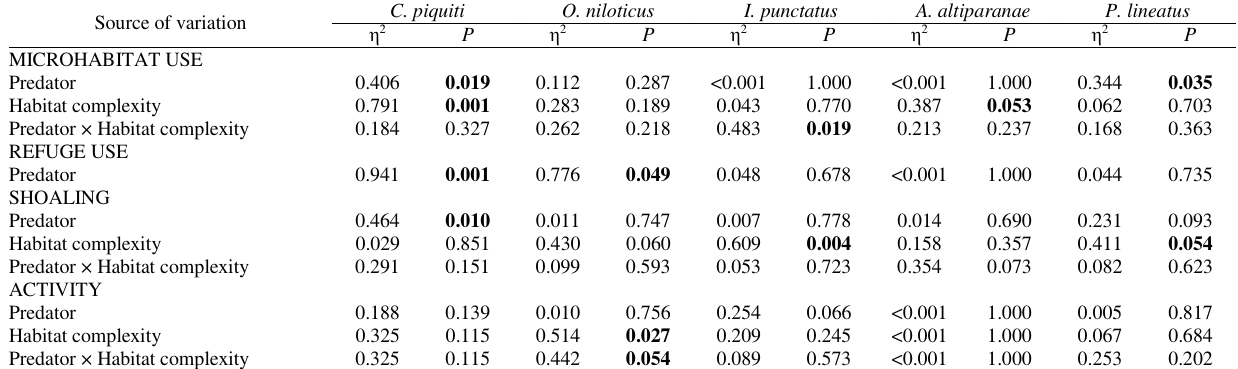
Table 2. Effects of predator presence ( P. corruscans ) and habitat complexity on prey behavioral traits: between-subjects factors (Huynh-Feldt corrections) of repeated-measures analysis of variance. Bold values correspond to significant ( P < 0.05) between-subjects F values.